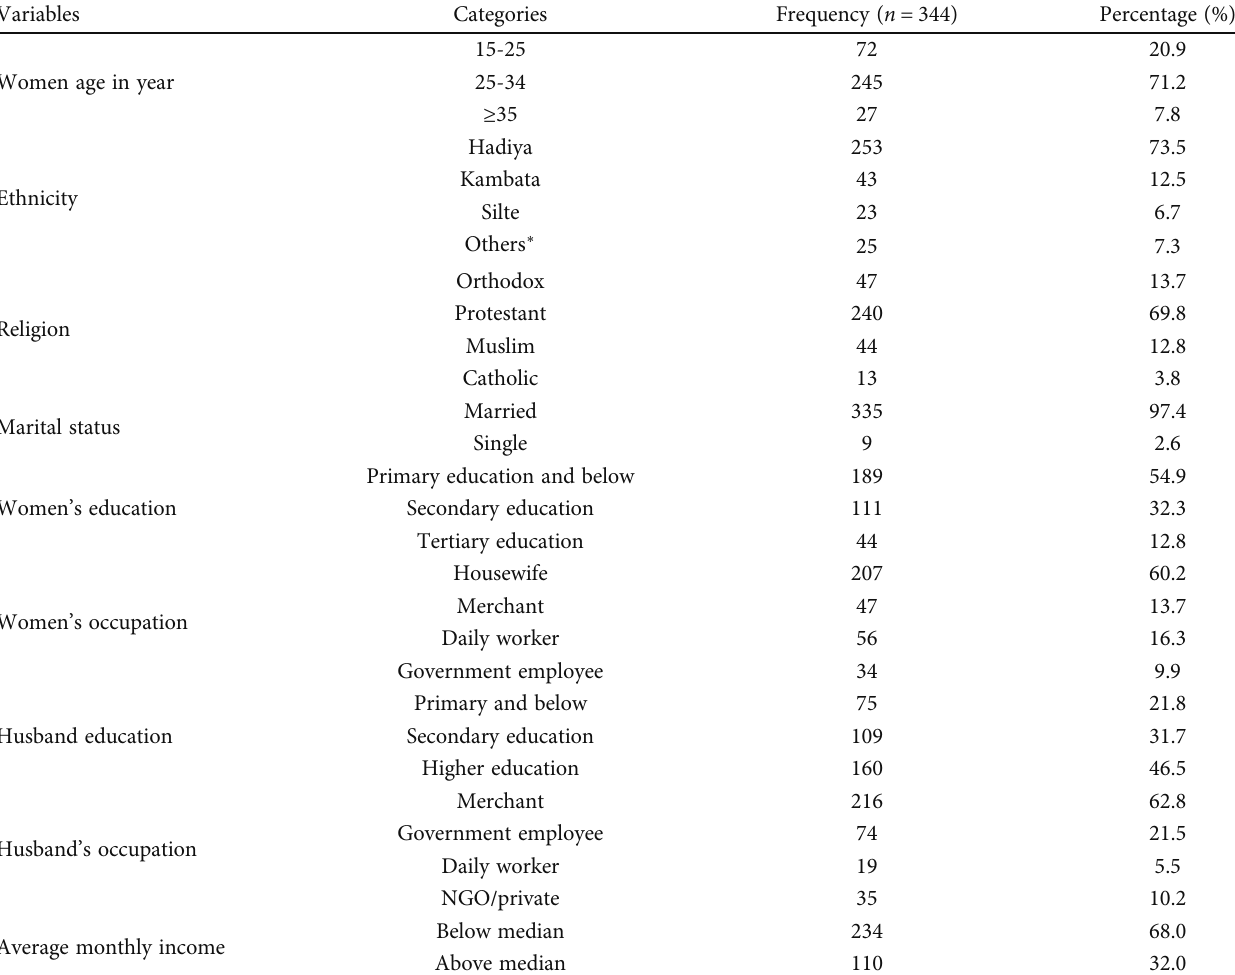
Table 1: Sociodemographic characteristics of pregnant women attending ANC at Wachemo University Nigist Eleni Mohammed memorial comprehensive specialized hospital Hossana, Ethiopia,